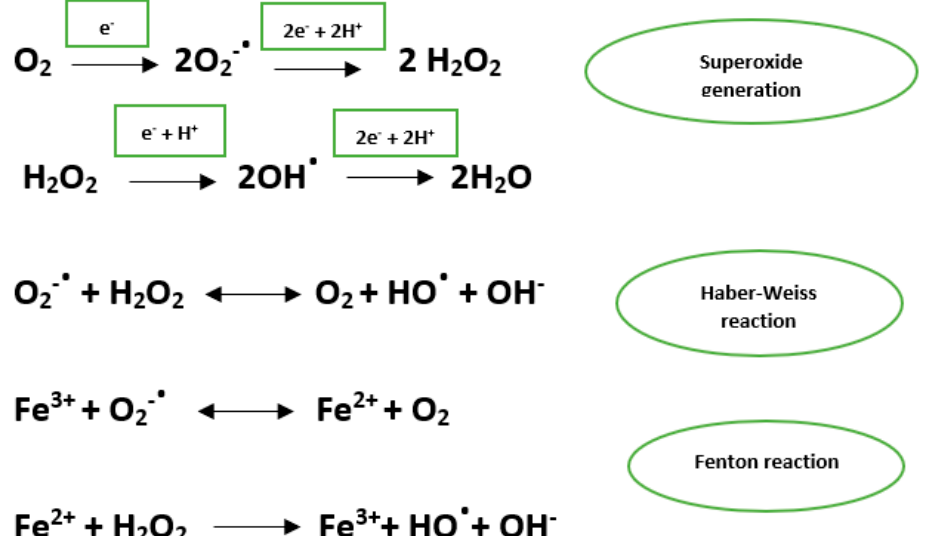
Figure 1. Superoxide generation through the reduction in oxygen and the generation of hydroxyl radical through Fenton and Haber Weiss reactions.